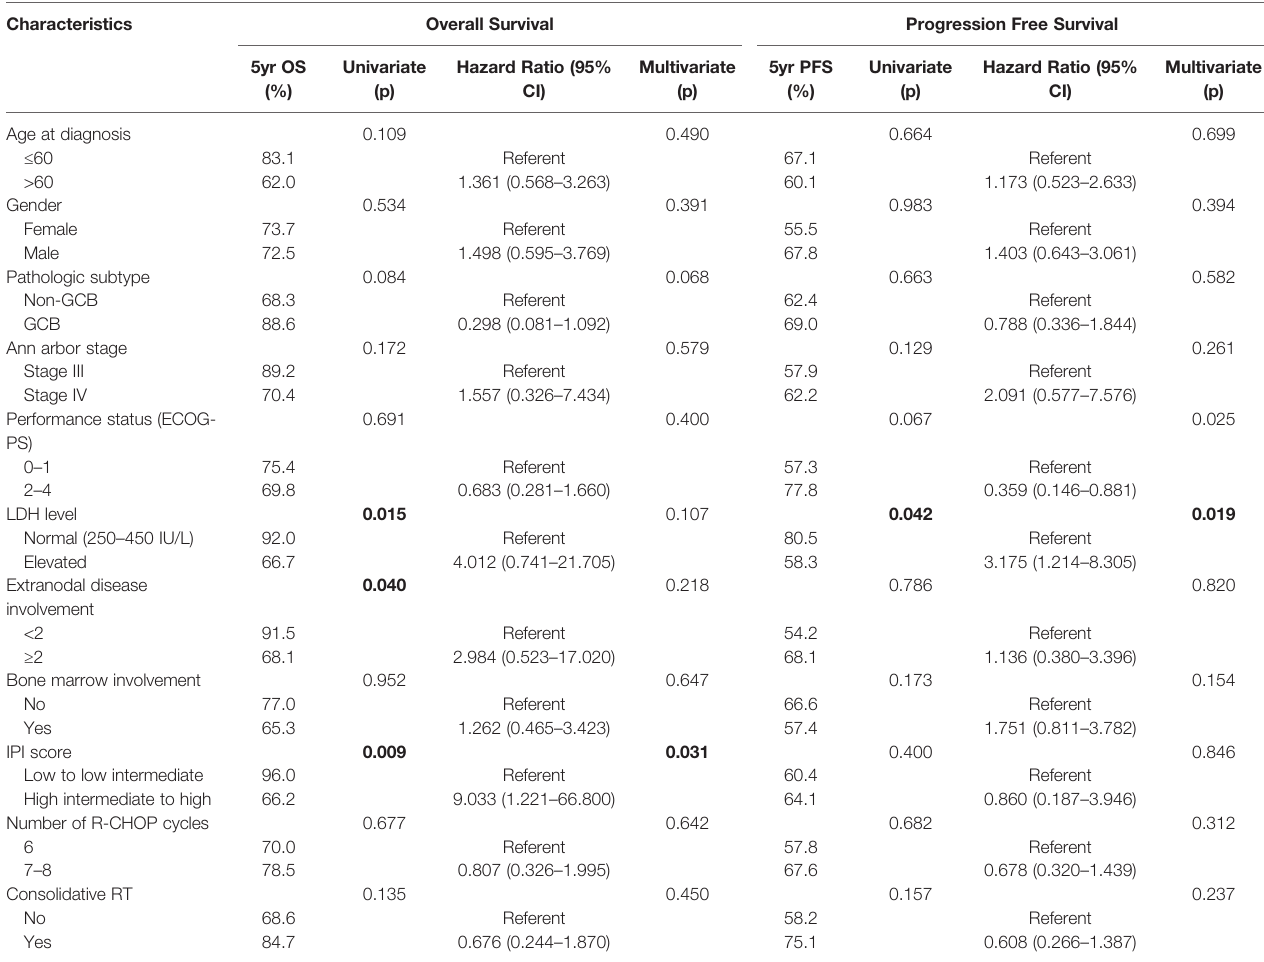
TABLE 4 | Univariate and Multivariate Analysis for Survival Outcomes.